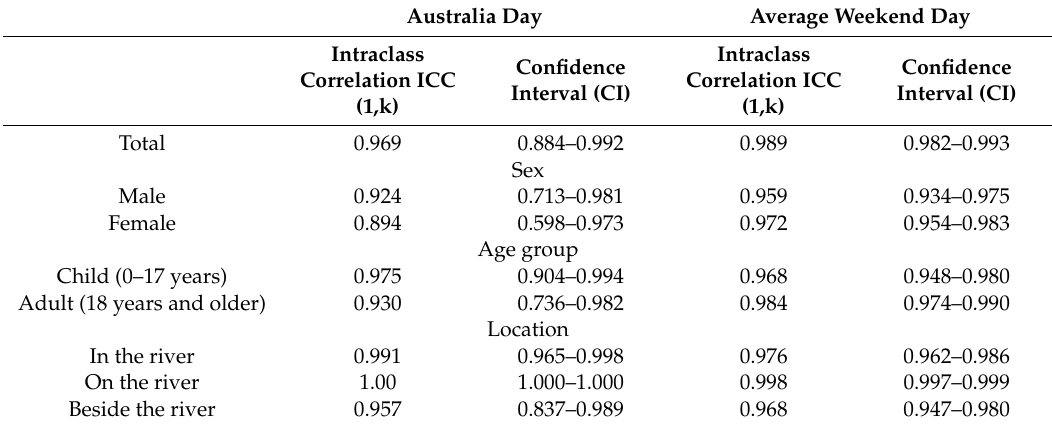
Table 6. Intraclass coe ffi cient calculations (ICC 1,k) for Australia Day compared to an average